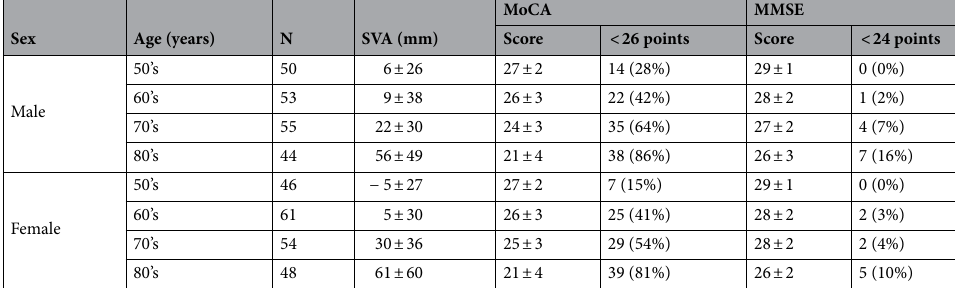
Table 1. Spinal alignment parameter findings, cognitive function test scores, and prevalence rates of cognitive impairment. Values represent the mean ± standard deviation or number of cases concerned (rate). The maximum MoCA score is 30 points, with a score of ≥ 26 considered normal (i.e., without cognitive decline). The maximum MMSE score is 30 points, with a score of ≥ 24 regarded as normal (i.e., without suspected